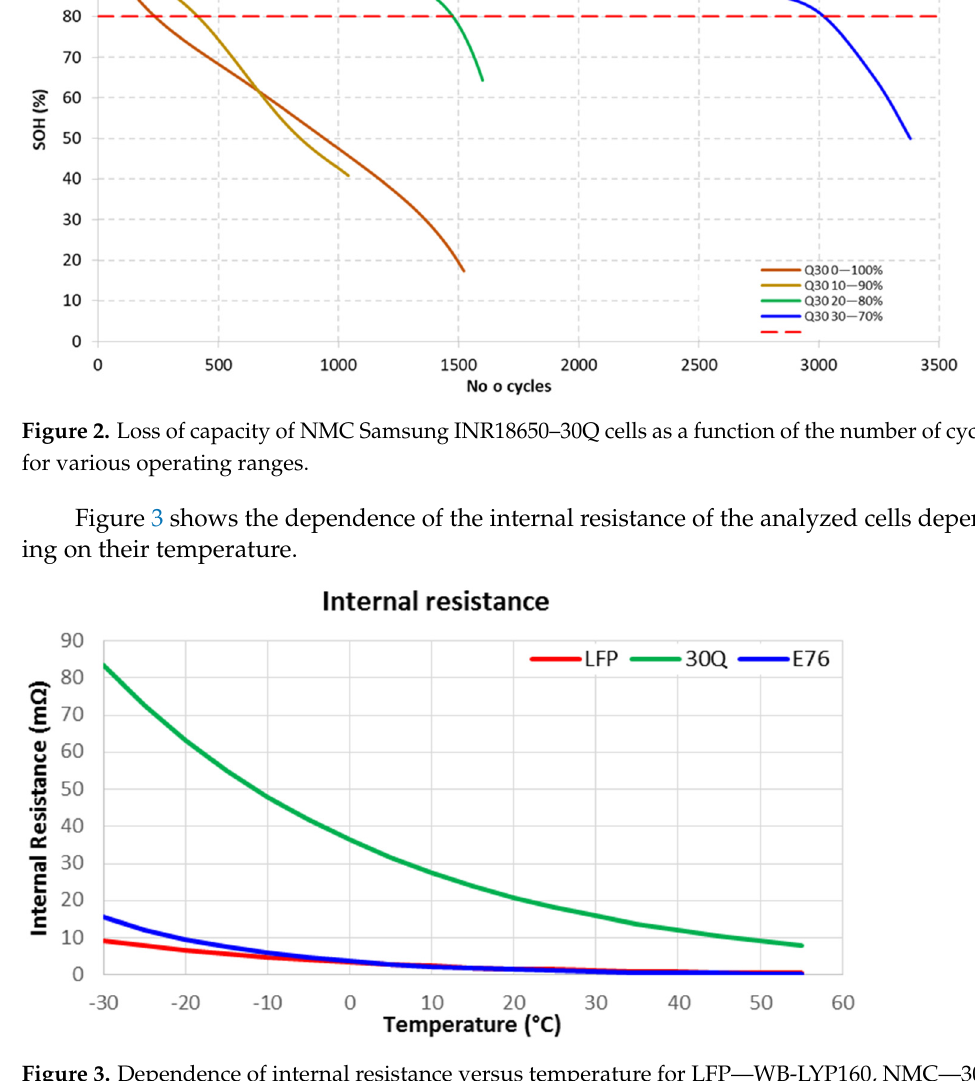
Figure 3. Dependence of internal resistance versus temperature for LFP—WB-LYP160, NMC—30Q, NMC—E76 (at load of 1C).